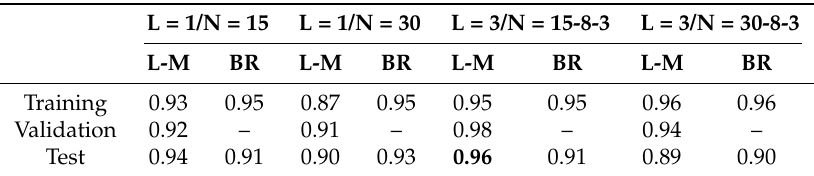
Table 4. Classification accuracy of different ANN configurations comparing SAM responses with